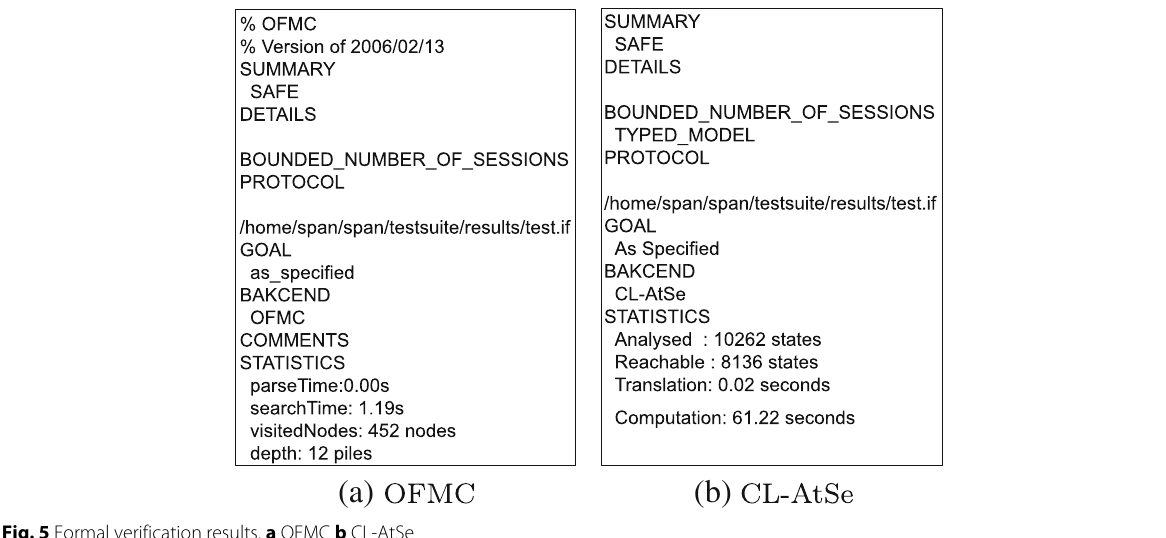
al.’s scheme [11], since there are no shared secrets between foreign cluster heads and mobile nodes, a foreign clus- ter head cannot verify the reauthentication request of a mobile node and unconditionally forwards it to the home cluster head. This leads to DoS attacks on the home clus- ter head. In contrast, ESMR can prevent unconditional